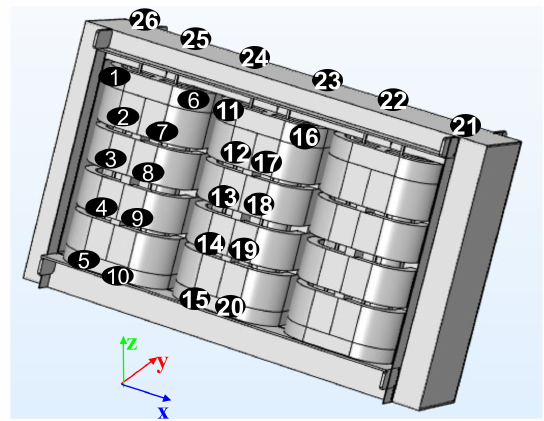
Figure 18. Measured point distributions of short-circuit vibration.